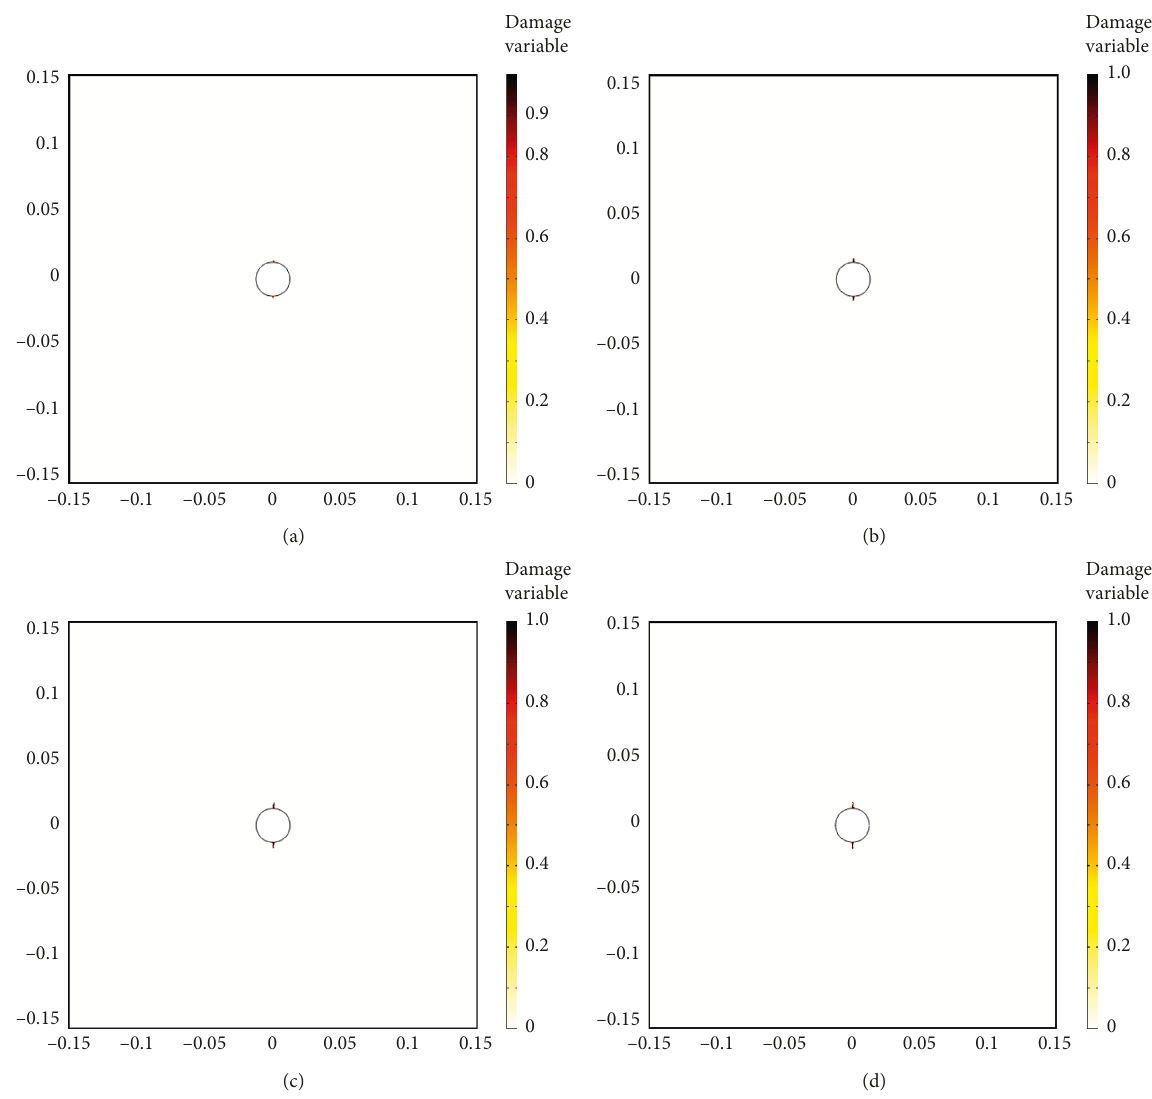
Figure 9: Distribution of initial cracks around borehole ( p